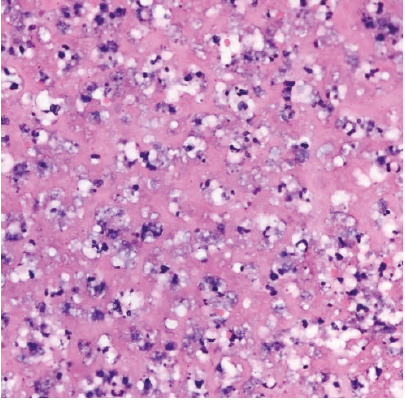
Figure 6: At the periphery of the thrombus with viable cellular material, clusters of foamy macrophages or foam cells can be